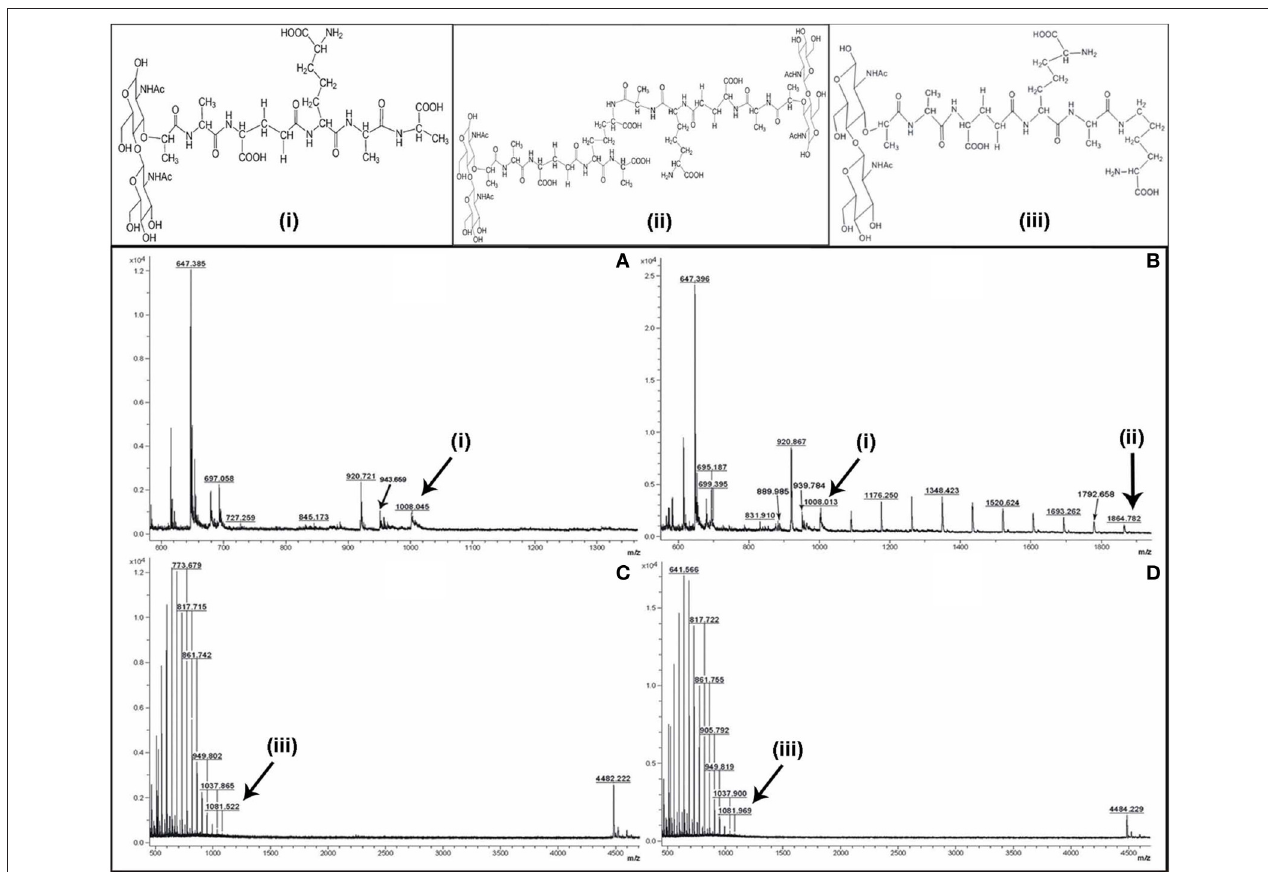
FIGURE 1 | Positive reflector ion MALDI mass spectrum of the digested peptidoglycan fragments of vancomycin-treated (A,C) and -untreated (B,D) cells of T. hydrothermalis SLCR_1D (Upper panels A,B) and A. kashmirensis WT 001 (Lower panels C,D). Structure (i) corresponds to muro-pentapeptide precursor having terminal alanine-alanine dipeptide, (ii) corresponds to tetrapeptide-tetrapeptide cross linking, whereas structure (iii) represents muro-pentapeptide precursor having terminal alanine-lysine dipeptide.